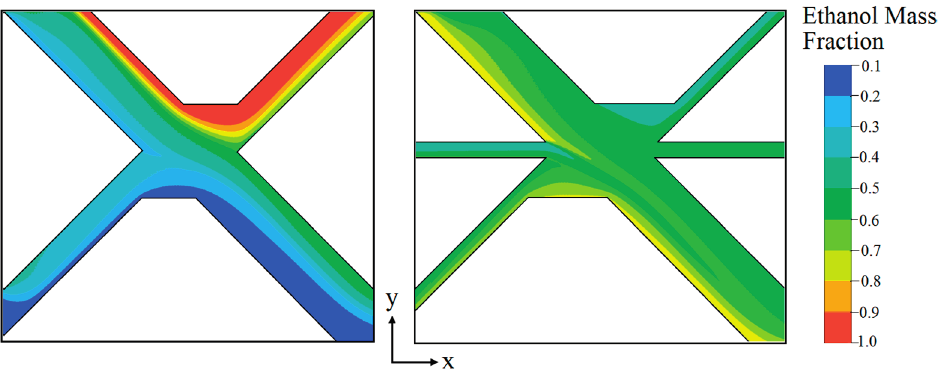
Figure 5. Concentration distributions of ethanol on the x - y plane at Re = 40 in the region indicated in Figure 4 in unbalanced two-split and three-split rhombic